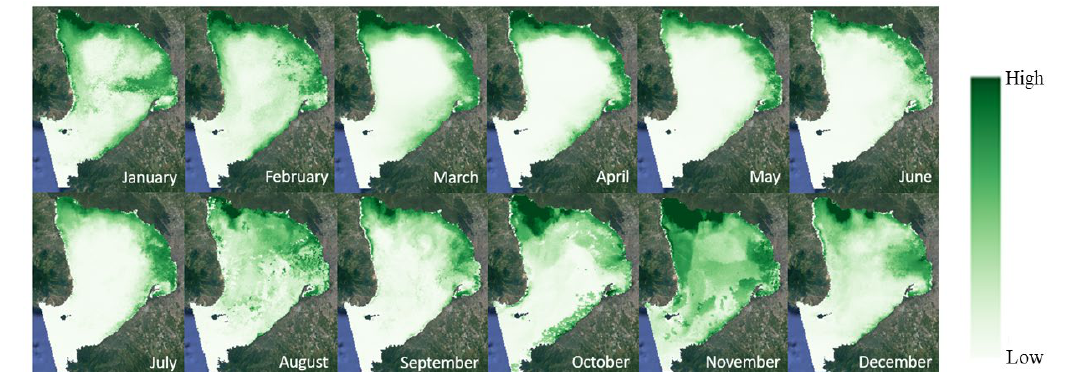
Figure 4. Chlorophyll-a distribution in Manila Bay for 2020. Darker green areas indicate higher concentration. High values are consistently present in the nearshore areas, but these spread into other parts of the bay during the wet